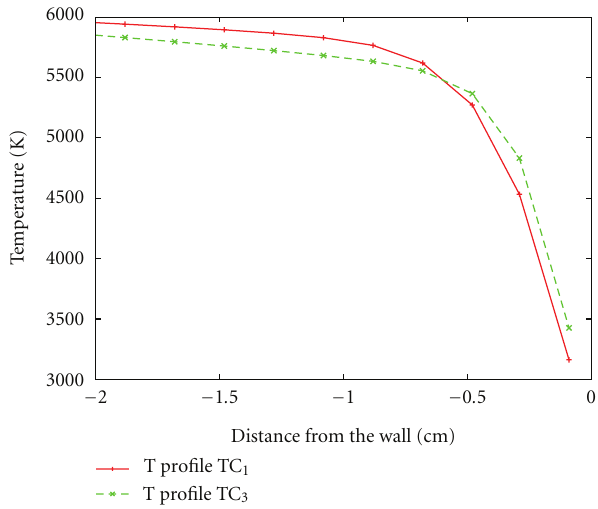
Figure 11: Detailled temperature profiles among stagnation line for TC 1 and TC 3